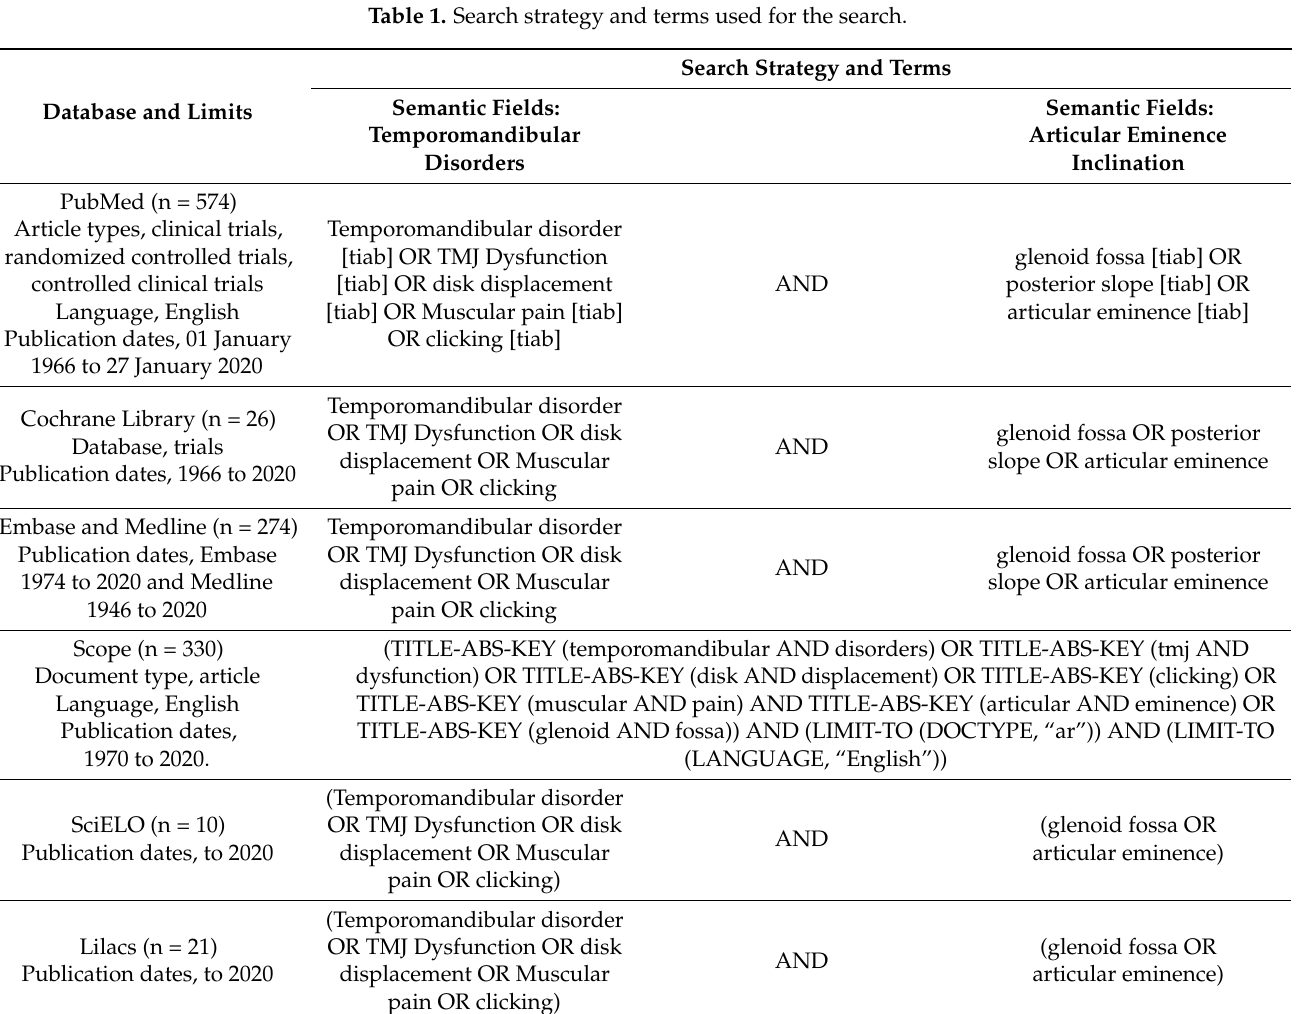
Table 1. Search strategy and terms used for the search.